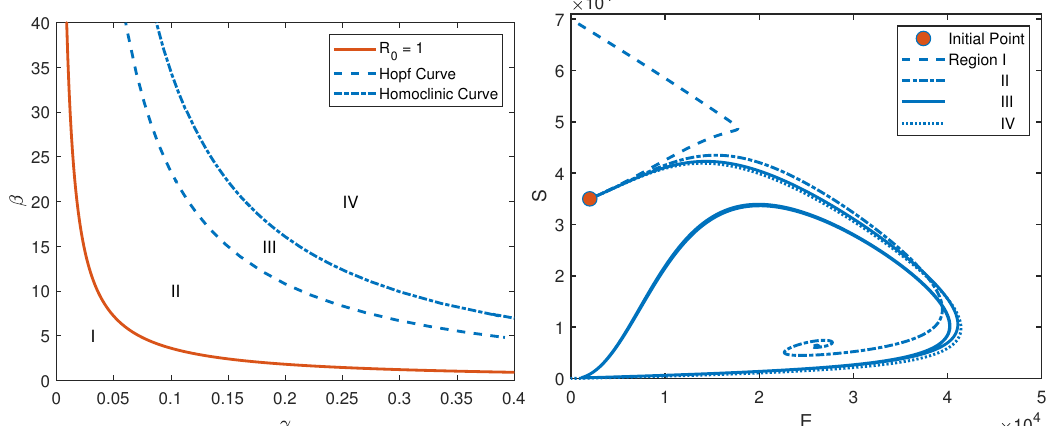
Figure 1. ( β , γ )-parameter plane for r = 1. Below the solid orange curve (region I), the system remains disease-free, whereas, rabies persists beyond this curve. Region III represents the ranges for β and γ , which lead to periodic oscillatory solutions. The population becomes extinct in region IV. The figure on the right shows the trajectories corresponding to the four different regions of the bifurcation